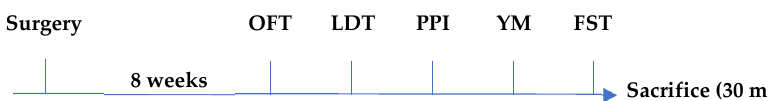
Figure 5. Timeline of behavioral tests.